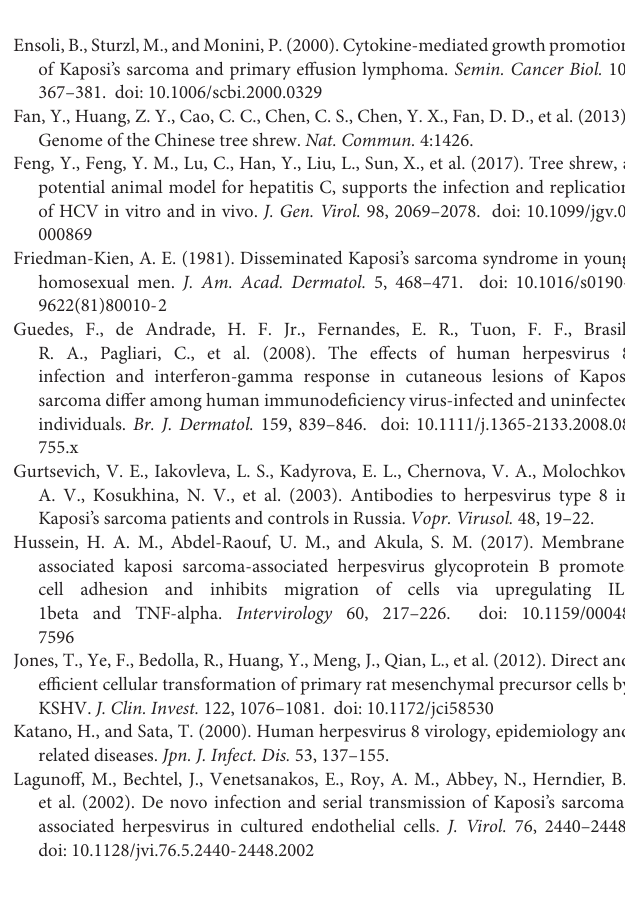
Supplementary Table 7 | Summary of rKSHV.219 infection in tree